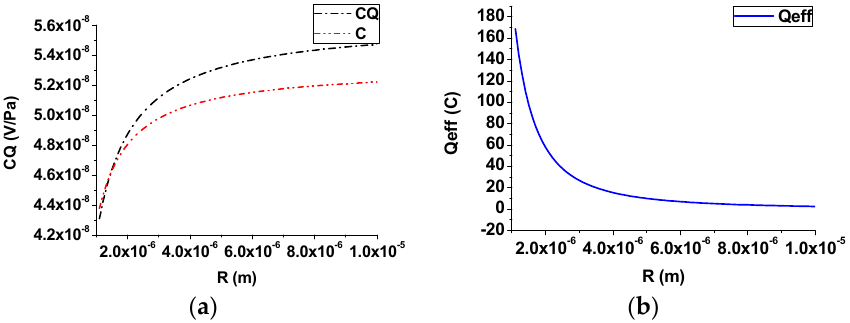
Figure 7. Effect of the pore size (steady case): ( a ) streaming potential coupling coefficient; ( b ) effective net residual charge density.